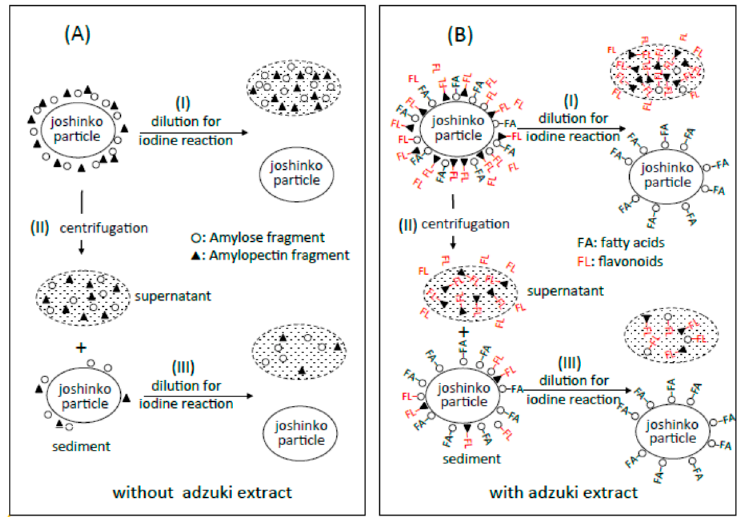
Figure 3. Possible schemes for the arrangement of amylose ( ○ ) and amylopectin ( ▲ ) around joshinko particles in retrograding joshinko. ( A ) Without adzuki extract and ( B ) with 10 μ L of the adzuki extract. For details, see text.